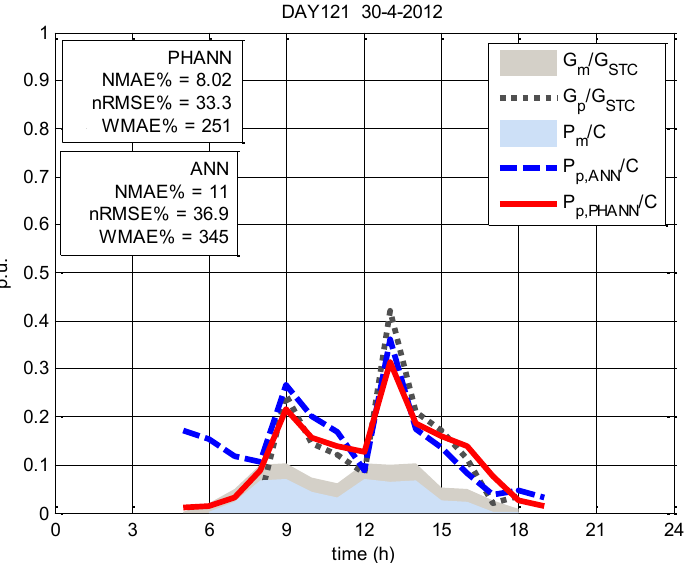
Figure 8. Power curves and daily error definitions applied to the forecasts in a cloudy day. These trends are in agreement with the weather forecast provided by the Meteo